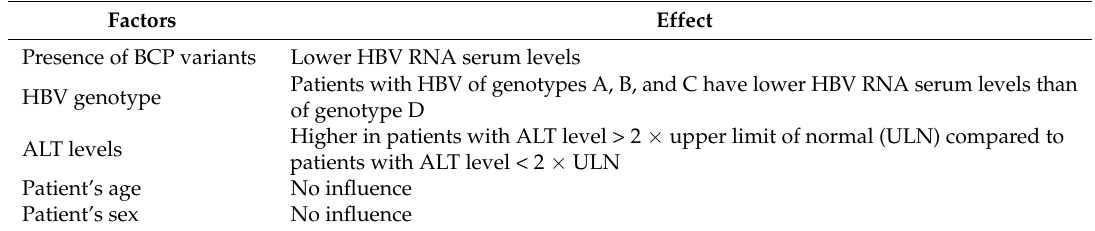
Table 3. Factors affecting HBV RNA levels in serum.